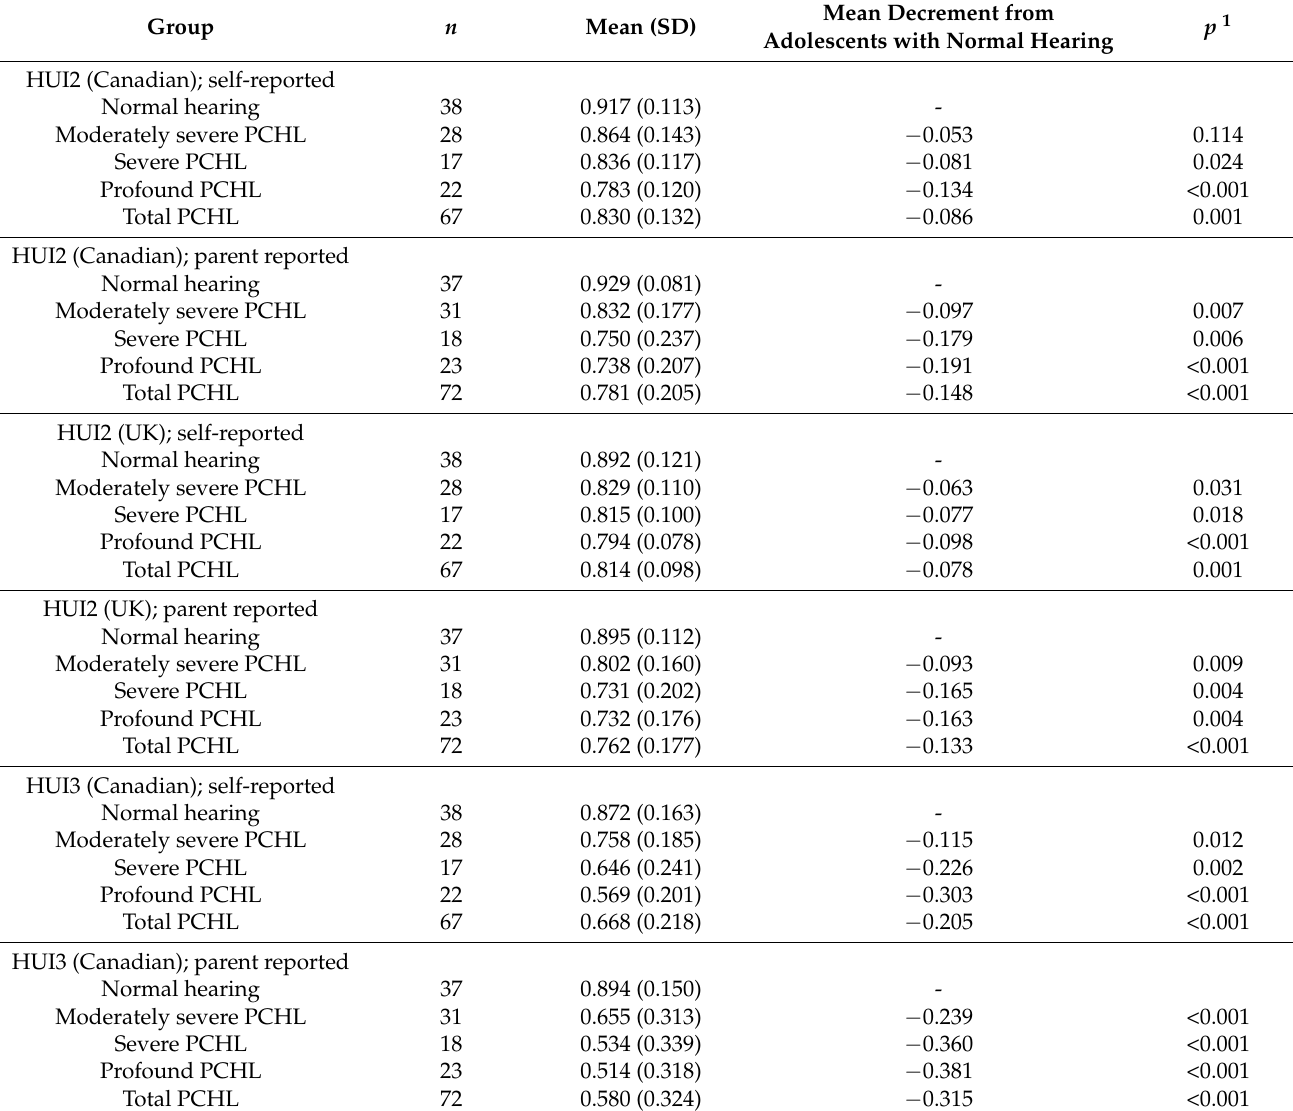
Table 2. HUI multi-attribute utility scores in adolescents with normal hearing and with